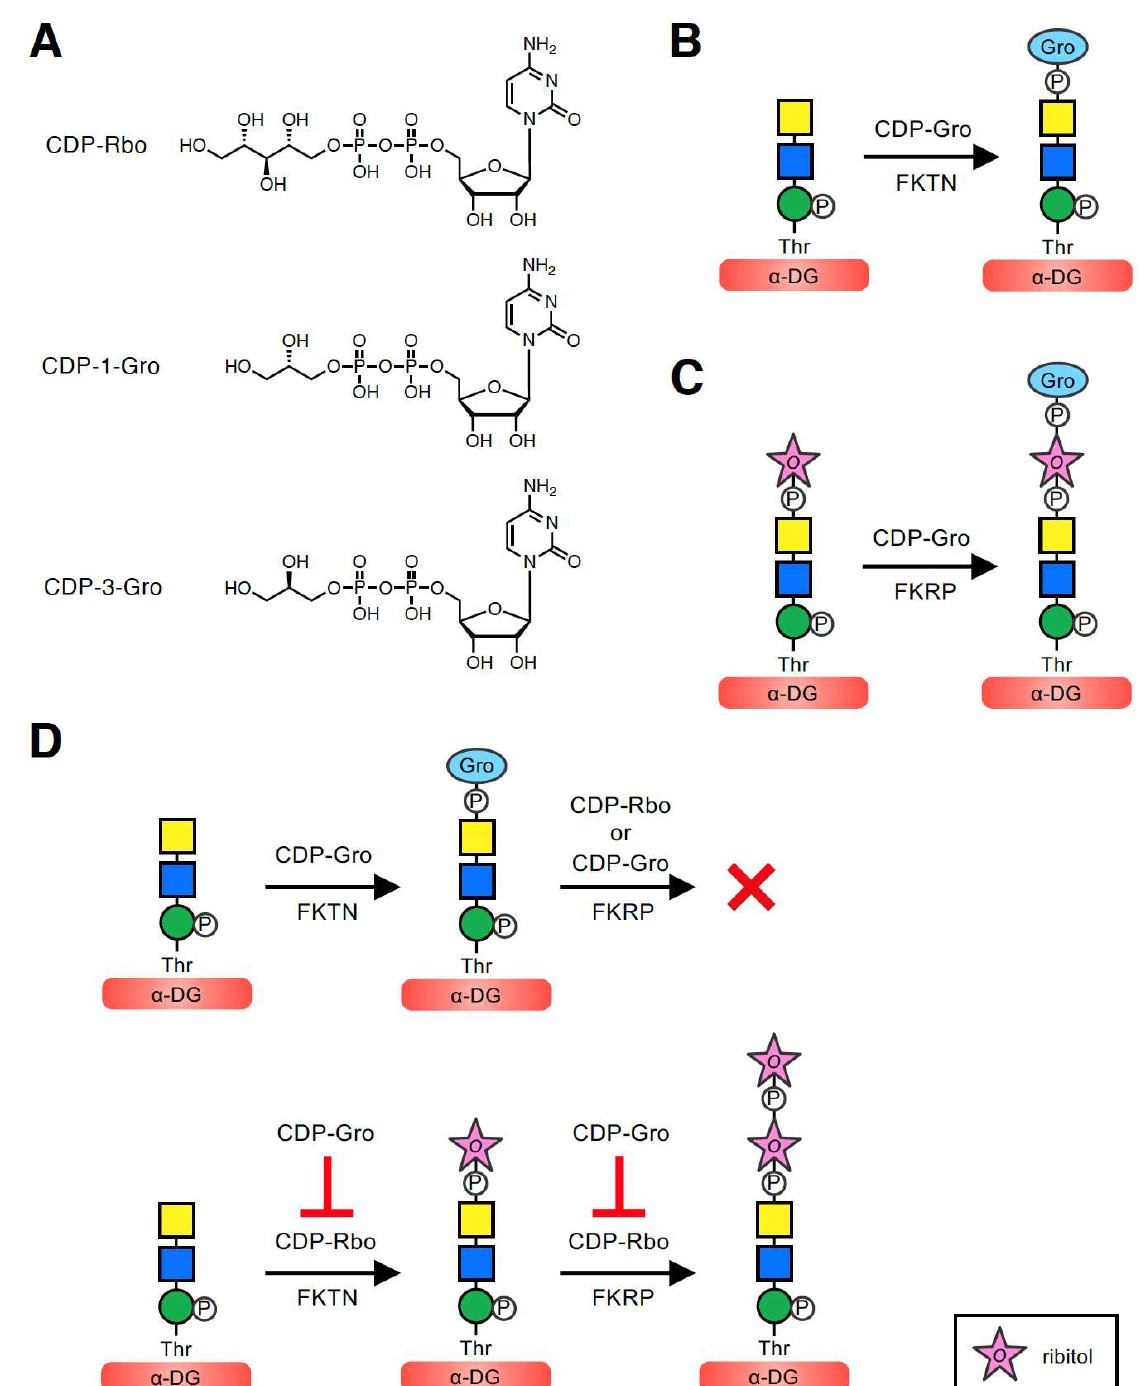
Figure 2. GroP transfer activities of FKTN and FKRP using CDP-Gro and the inhibitory effect of CDP-Gro on elongation of core M3-type glycan. ( A ) Structures of CDP-Rbo and CDP-Gro. The two stereoisomers of CDP-Gro, CDP-1-Gro and CDP-3-Gro, are shown. CDP-Rbo is defined as CDP-5-D-Rbo. CDP-1-Gro and CDP-3-Gro are defined as CDP-1-L-Gro and CDP-3-L-Gro, respectively. ( B ) FKTN transfers GroP from CDP-Gro to the terminal GalNAc of the phospho-core M3 structure. ( C ) FKRP transfers GroP from CDP-Gro to the terminal Rbo5P of the Rbo5P-(phospho)core M3 structure. ( D ) CDP-Gro inhibits elongation of the core M3-type glycan by two mechanisms. ( Upper ) When CDP-Gro serves as the donor substrate for FKTN, the GroP-transferred product does not serve as the acceptor substrate for FKRP, and further extension of the outer glycan chain cannot occur. ( Lower ) CDP-Gro competitively inhibits the Rbo5P transfer reaction from CDP-Rbo of both FKTN and FKRP, also preventing elongation of the outer glycan chain. The symbol legend for ribitol is indicated in the lower box. Other symbol legends are the same as in Figure 1C.